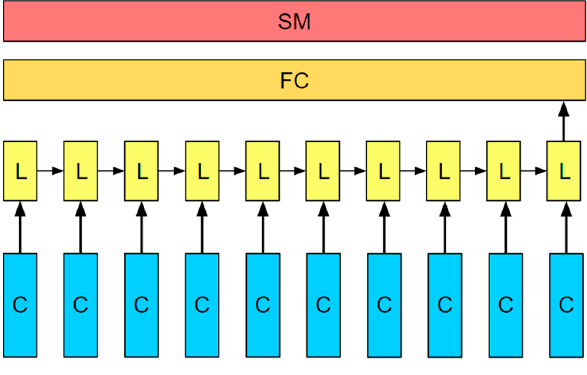
Figure 3. The structure of CNN-LSTM.